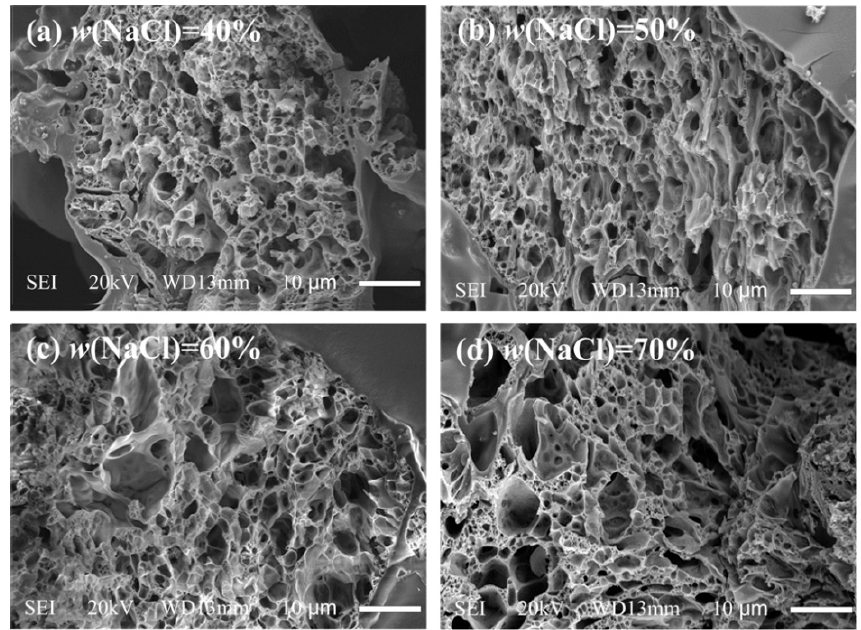
Figure 6. SEM images of the porous texture of porous UHMWPE/FANC 12.5 specimens with a 3% weight content of FANC 12.5 . The magnification is 3000×. ( a ) UHMWPE/FANC 12.5 (FANC 12.5 3%, NaCl 40%), ( b ) UHMWPE/FANC 12.5 (FANC 12.5 3%, NaCl 50%), ( c ) UHMWPE/FANC 12.5 (FANC 12.5 3%, NaCl 60%), ( d ) UHMWPE/FANC 12.5 (FANC 12.5 3%, NaCl 70%). Static water contact angles (CAs) and photographs of water droplets on the different specimen surfaces are depicted in Figure 7.